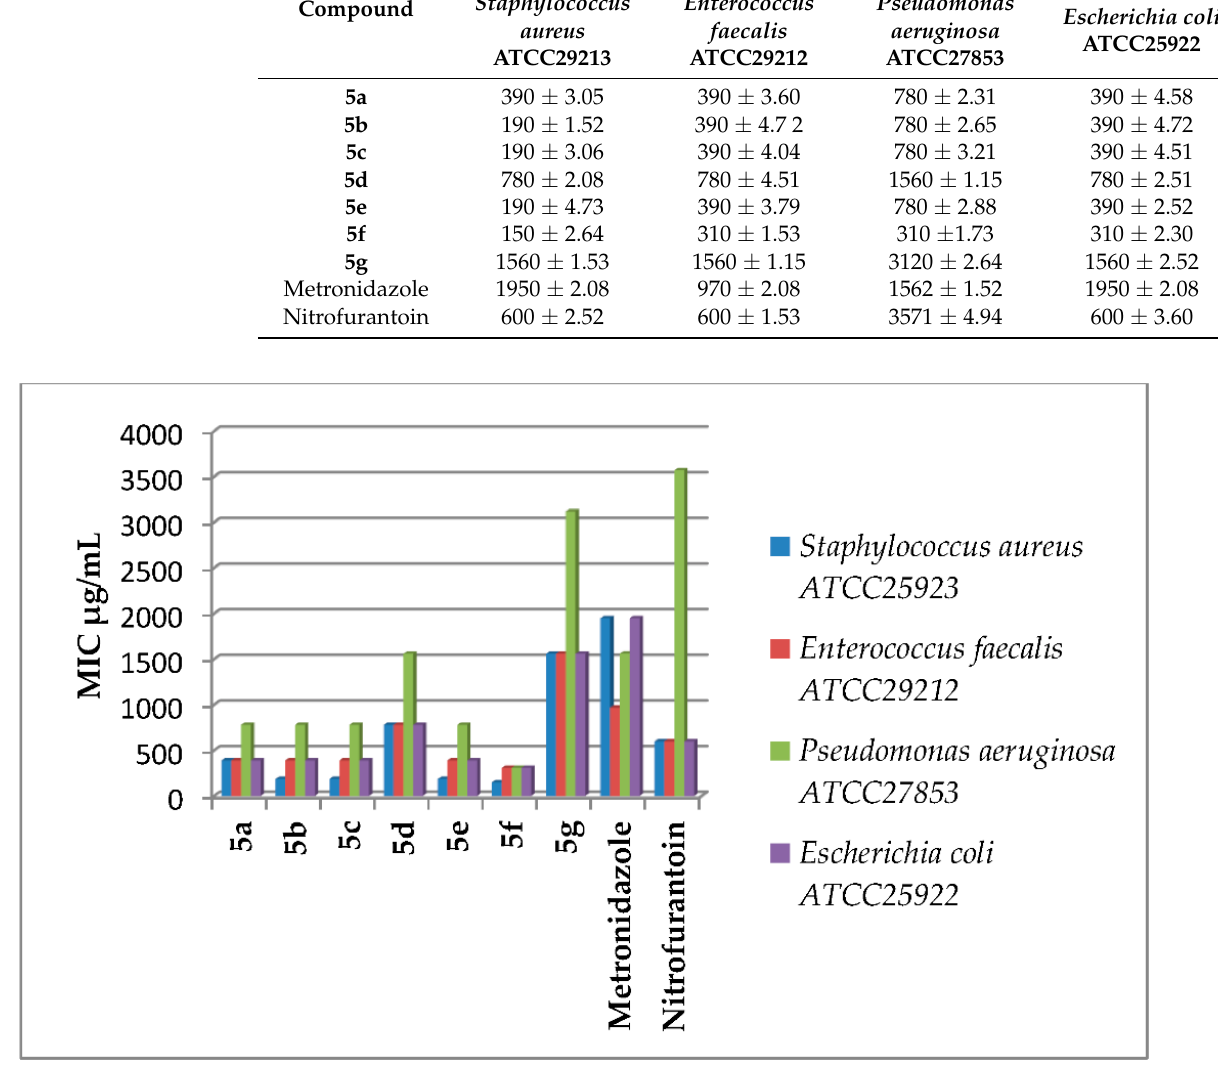
Figure 4. Molecular structure of reference drugs.